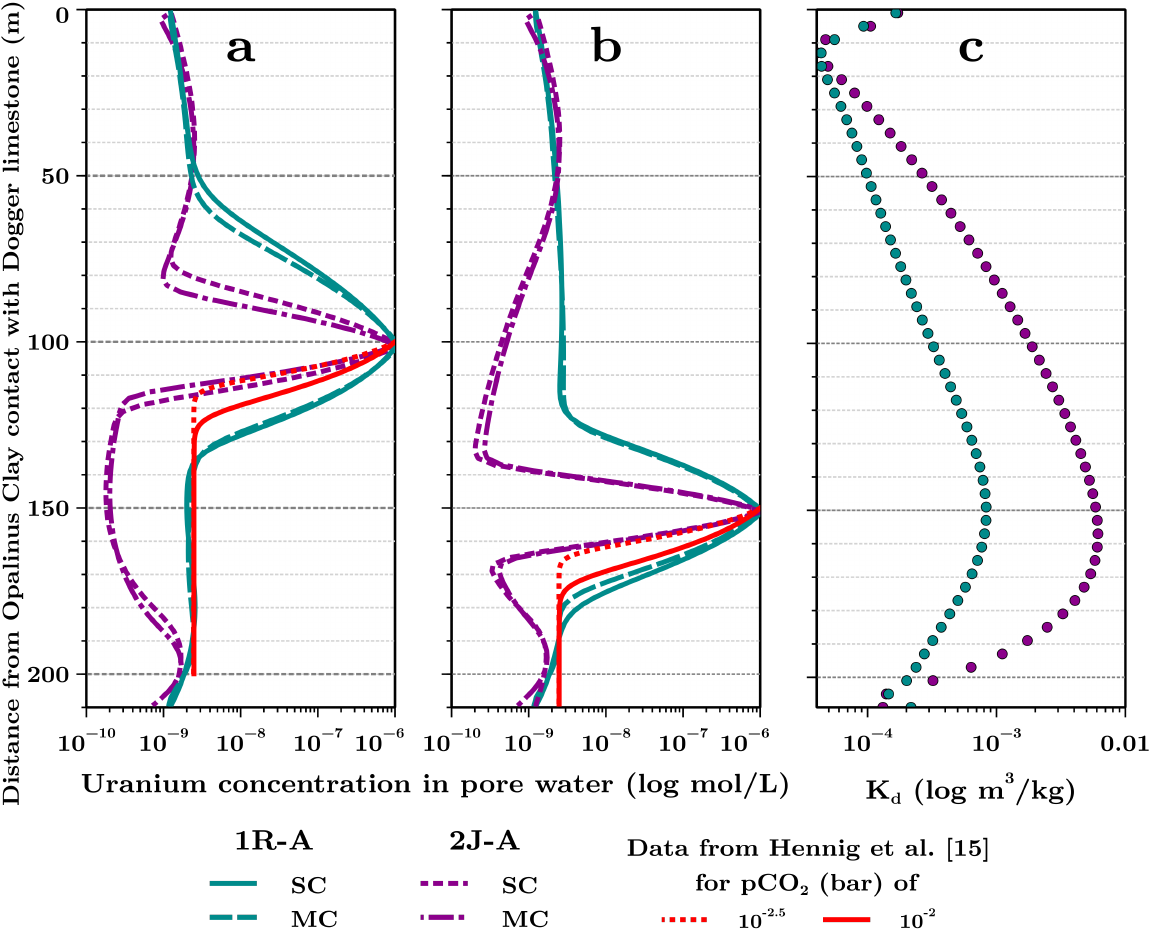
Figure 7. Migration of uranium in the Opalinus Clay formation is increased by + 4m to + 24m for heterogeneous systems compared to homogeneous models (red line, Ref. [16]). The uranium source term representing a potential repository was located at a distance of 100m ( a ) and 150m ( b ) below the contact Opalinus Clay and Dogger limestone (y-axis). SC and MC simulations were performed for scenario SC-1R-A (solid and dashed line) and MC-2J-A (dotted and dash-dotted line) and the corresponding distribution coefficients K d (m 3 /kg) of uranium between pore water and mineral phases ( c ) were